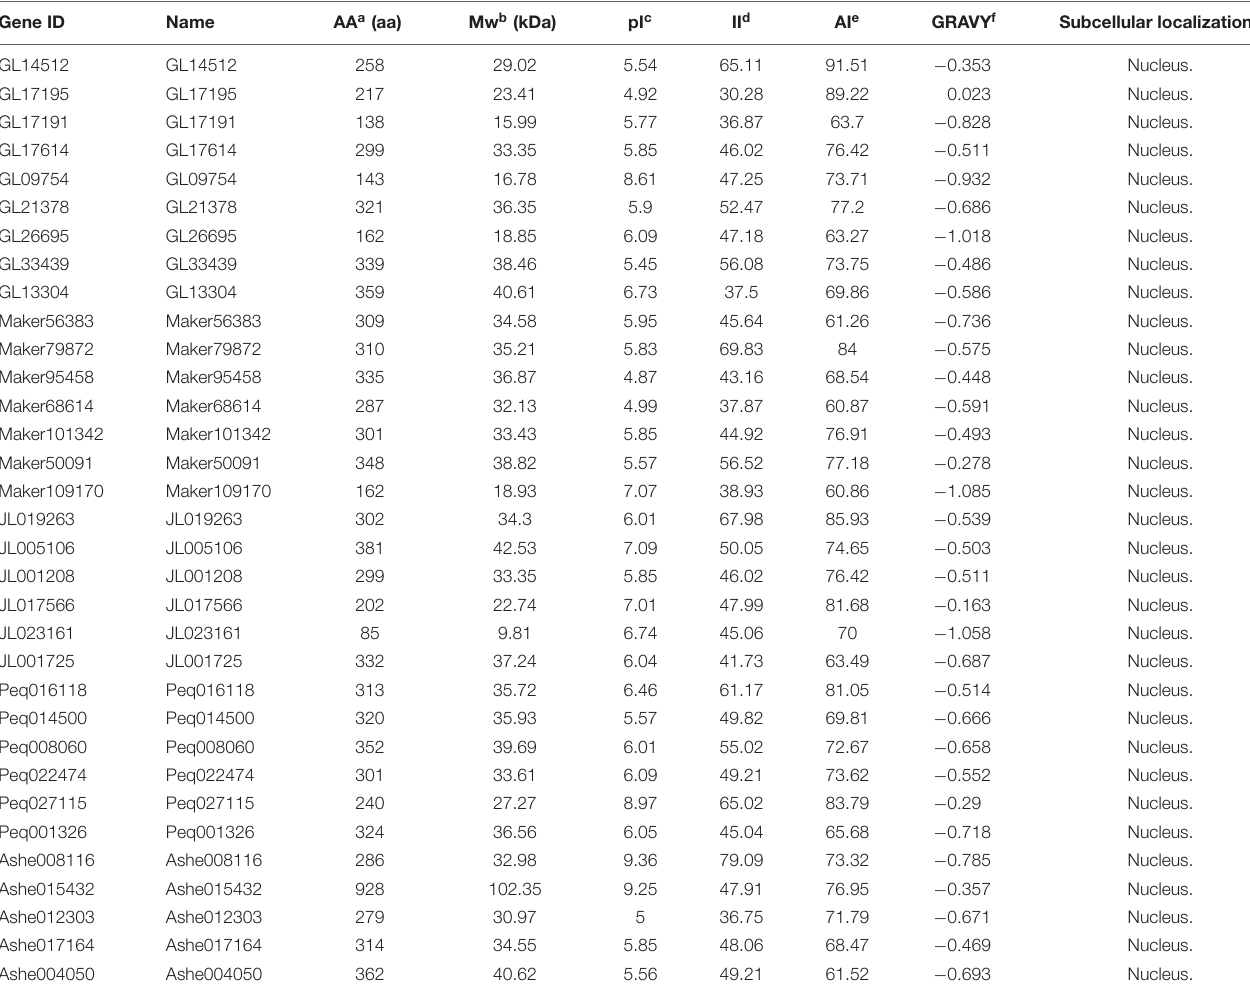
TABLE 1 | Physicochemical properties and subcellular location of KNOX